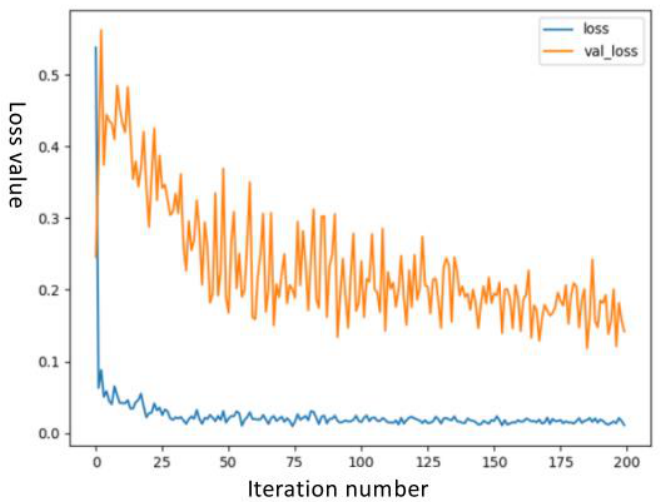
Figure 10. MSE on the training and validation sets.